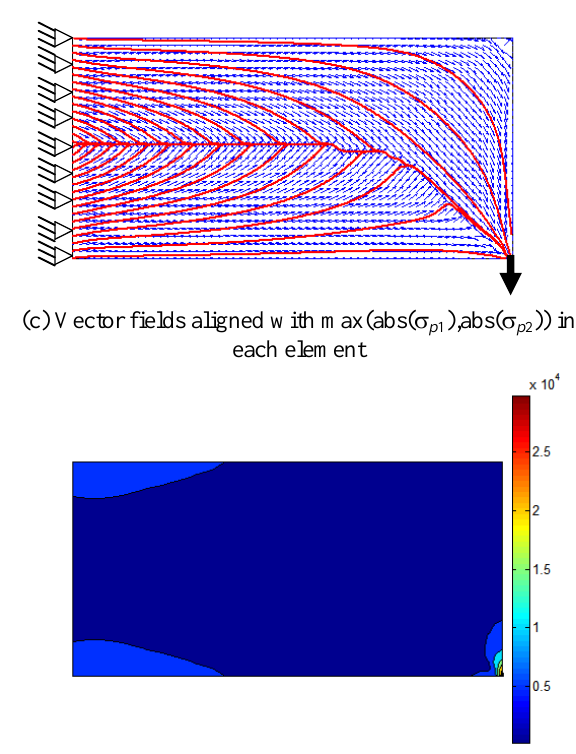
Fig. 13. Load paths based on principal stresses with left side of the structure fully constrained